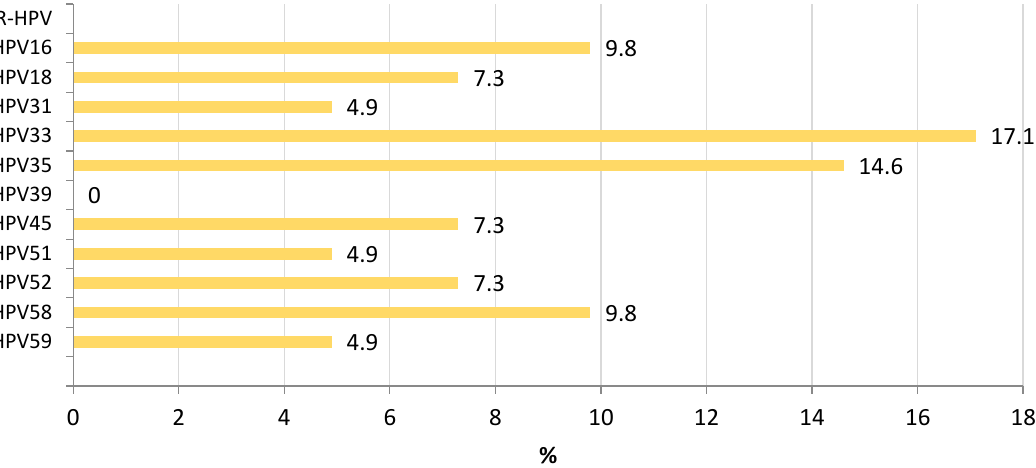
Figure 2. HPV33 (17.1%) and HPV35 (14.6%) were the most frequent types associated with